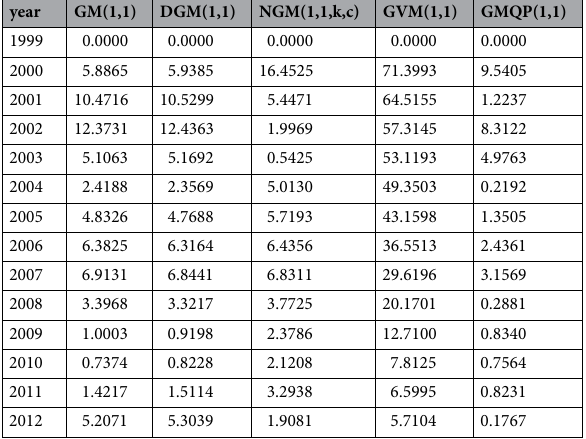
Table 3. The APEs of these forecasting models in the energy consumption of China.